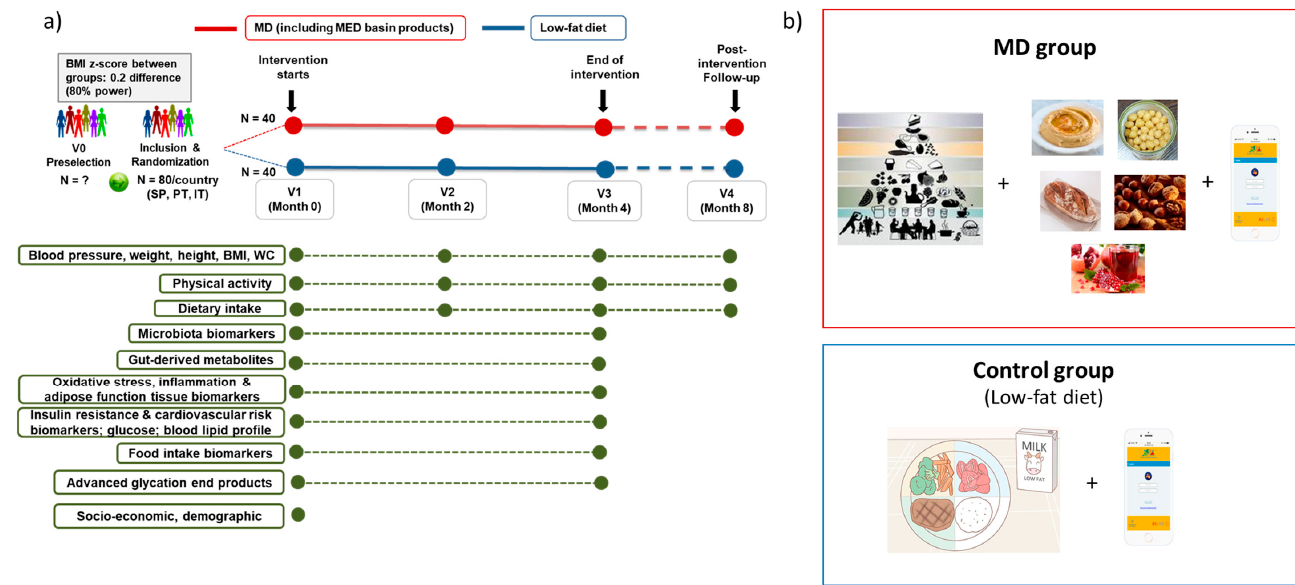
Figure 1. ( a ) Design of the Study. ( b ) Overview of the intervention groups. MD, Mediterranean Diet; MED, Mediterranean; BMI, Body Mass Index; ES, Spain; PT, Portugal; IT, Italy; V, Visit; WC, Waist Circumference.